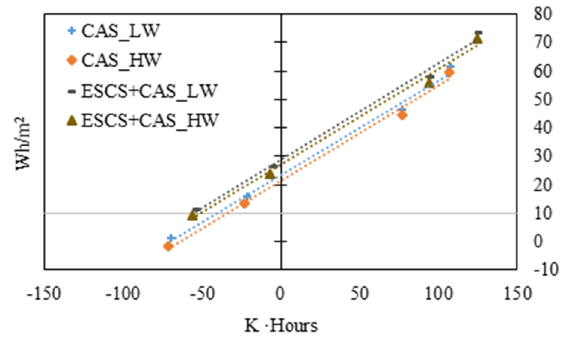
Figure 6. Composition of accumulated cooling load in perimeter zones with lightweight construction on a Nanjing cooling design day (embedded surface cooling system (ESCS)). Figure 7. Accumulated conduction heat transfer rate through an external wall against degree-hours. Table 2. The effects of thermal mass on thermal transmission (cooling design days).